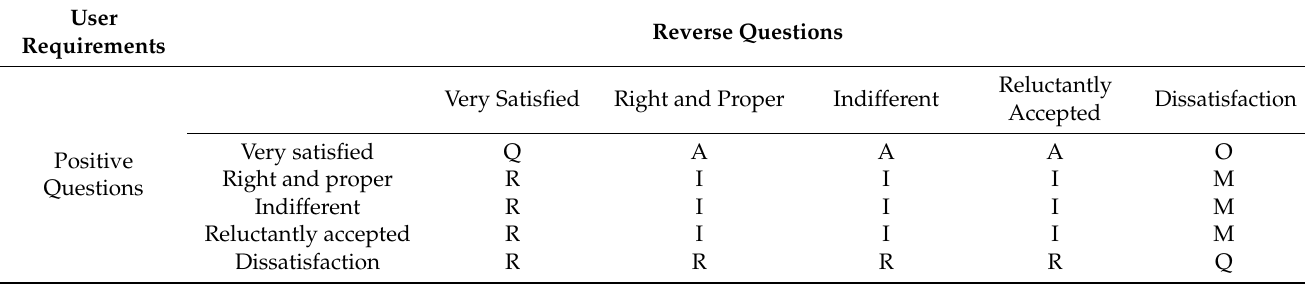
Table 1. Judgment matrix of the user demand Kano